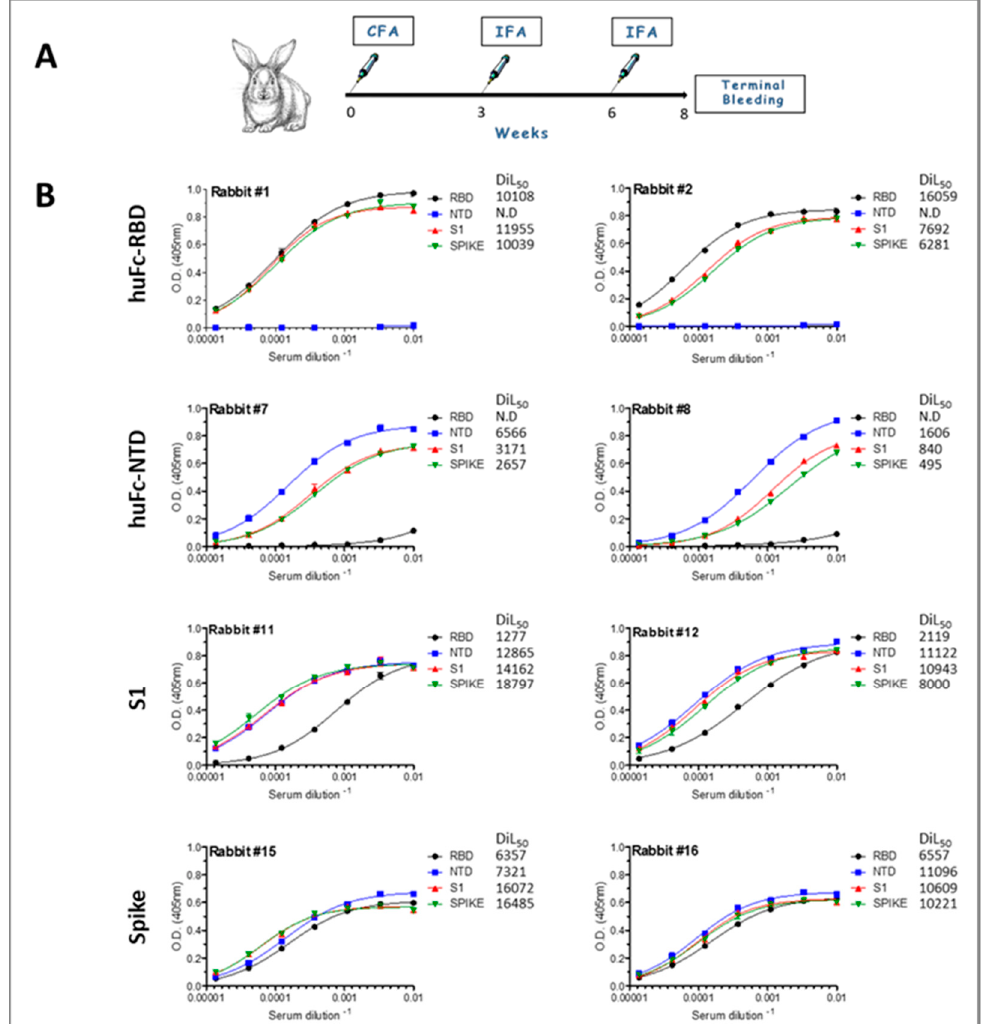
Figure 2. Anti-SARS-CoV-2 IgG antibody responses in immunized rabbits. ( A ) Rabbit immunization regimen scheme. ( B ) Binding curves of IgG polyclonal antibodies from rabbit sera (taken 10 days post the last boost) were obtained by ELISA against the indicated antigens. Antigens that were used to immunize each pair of animals are indicated on the left. Points are average of triplicates ±SEM fitted by non-linear regression and represent two independent experiments. The half-dilution value (DIL 50 ) for each antigen is presented.